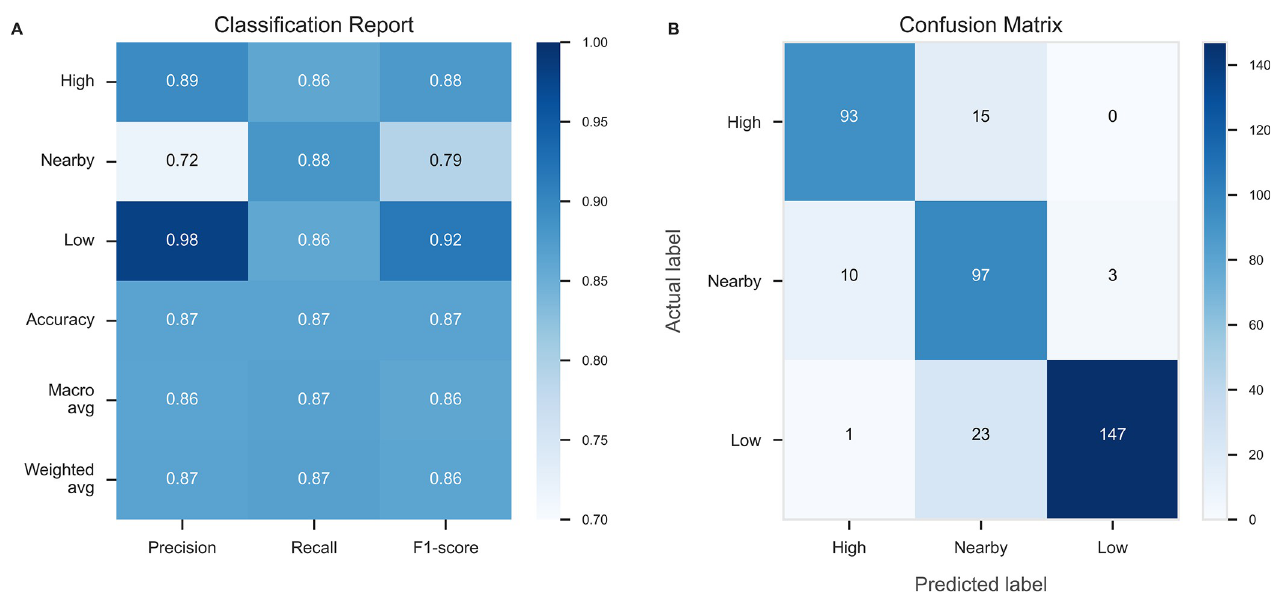
Fig 5. Evaluation metrics, including precision, recall, and F1-score assessing the performance of the RF model to classify each disposal label (A) . Confusion matrix of the RF model displaying correctly classified and misclassified disposal labels (B) .